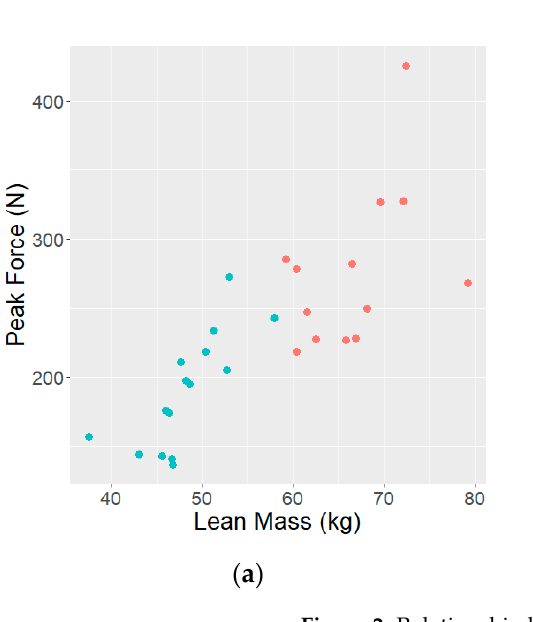
Figure 2. Relationship between lean mass and force production: ( a ) The relationship between peak force production (F peak ) and lean mass (FFM) during a TST. ( b ) The relationship between average force production (F mean ) and lean mass (FFM) during a TST.